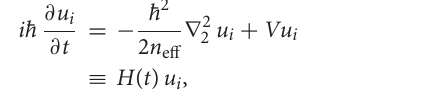
FIGURE 5 | Calculated m -dependence of the two split modes, TE + 1 (blue curve) and TE − 1 (red curve), produced from a mode-crossing point at 190.13 THz with k 0.2925 2 π/ a of a degenerated TE 1 mode. The centre of the = × TE + 1 and TE − 1 modes has little m -dependence, as indicated by the black dashed curve. The gap size f between the TE + 1 and TE − 1 modes increases with m , and the maximum gap size f max ( 8.68THz) is obtained at m / a 0.5. = = The inset shows the m -dependence of f / f max by the green dots, where the green dots at m / a . 0.3 fit well with the black dashed line with f / f max gm / a ( g = =